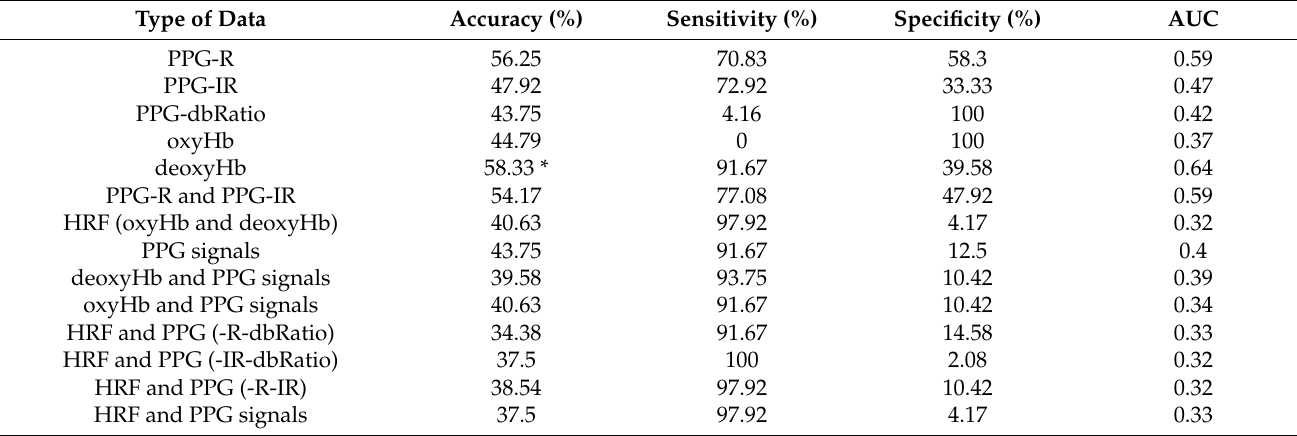
Table 1. Support vector machines with linear kernel function; all signals were photoplethysmography signals (PPG-R, PPG-IR, and PPG-dbRatio) and hemodynamic response function (oxyHb and deoxyHb) signals. The superscript asterisk is the best in table of accuracy.